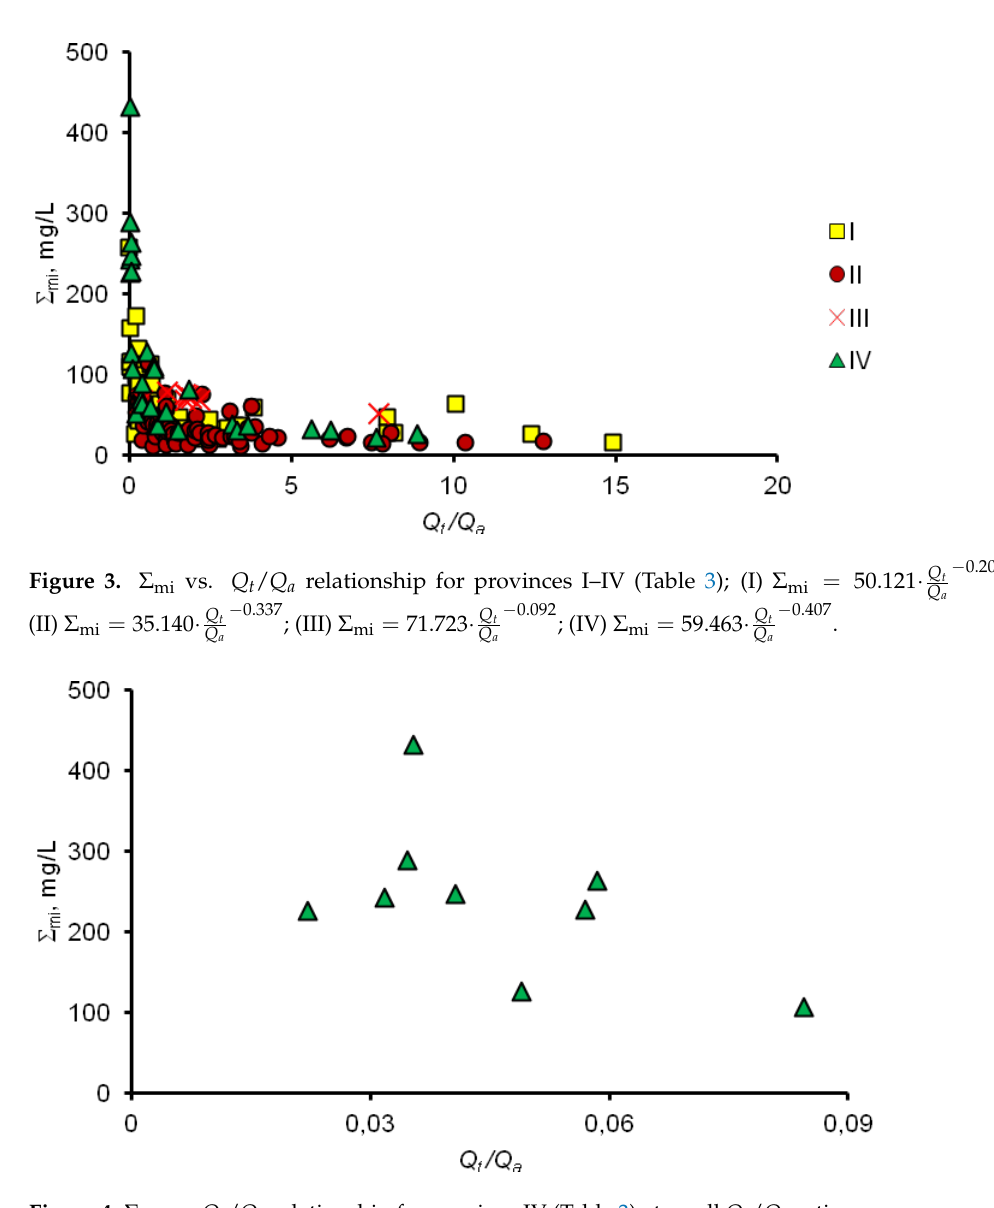
Figure 4. Σ mi vs. Q t / Q a relationship for province IV (Table 3) at small Q t / Q a ratios.